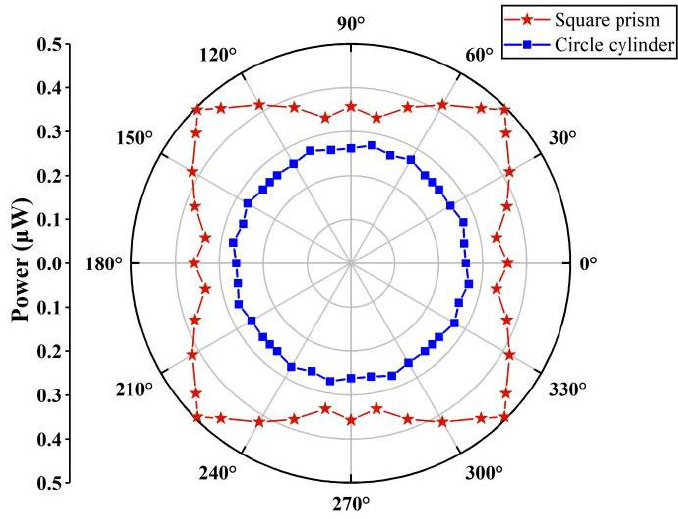
Figure 8. Power responses of the harvester with square prism and circle cylinder at a wind speed of 8 m/s.